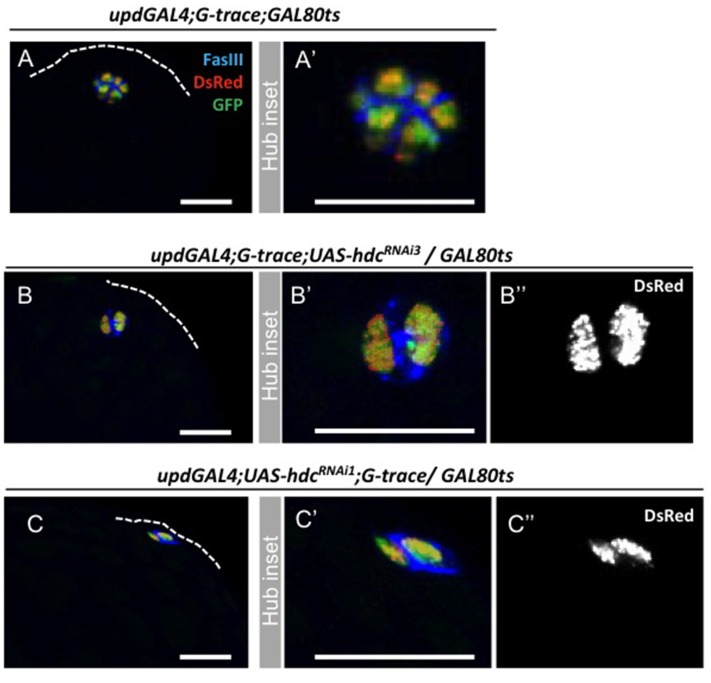
Hub cell conversion to the cyst cell lineage does not happen after hdc loss-of-funtion in the hub.Lineage-tracing analysis using G-TRACE in (A, A’) controls (genotype: updGal4;G-TRACE;Gal80ts) or (B–C”) upon loss of hdc function (genotypes: updGal4;G-TRACE; UAS-hdcRNAi3/Gal80ts and updGal4;UAS-hdcRNA1;G-TRACE/Gal80ts) shows restricted expression of dsRed and GFP in hub cells. (B” and C”) Note no change in the levels of upd promoter activity (DsRed) was observed in the different categories of hub cell loss.